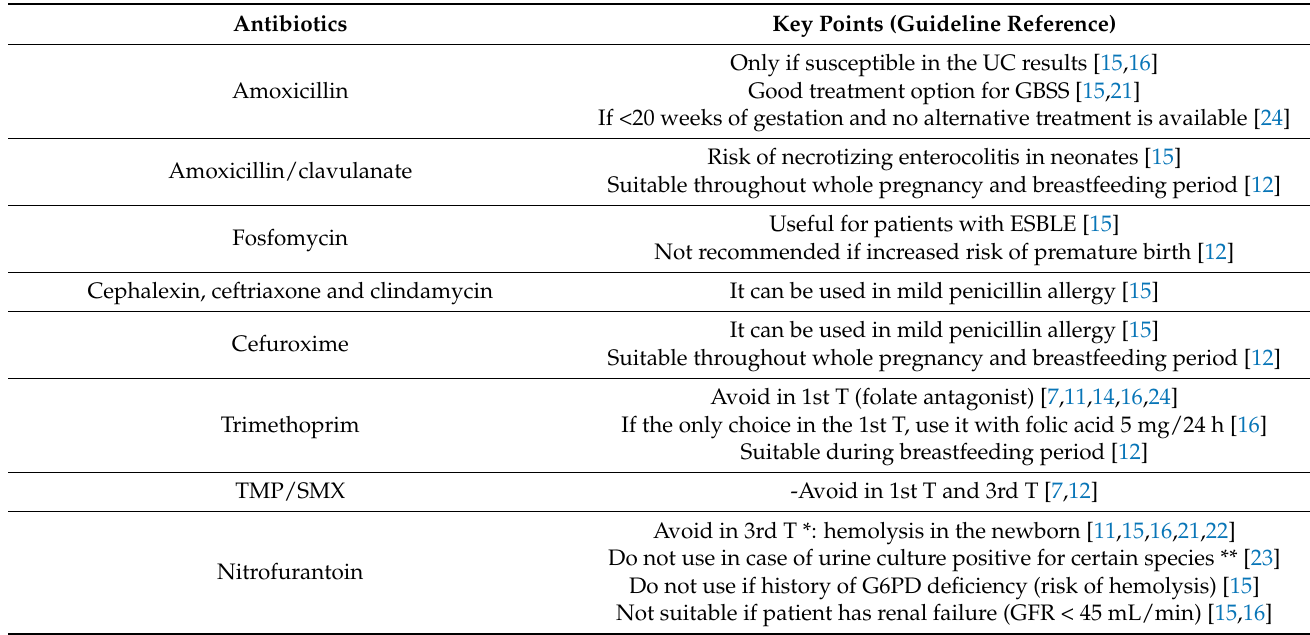
Table 2. Key points of frequently used antibiotics during